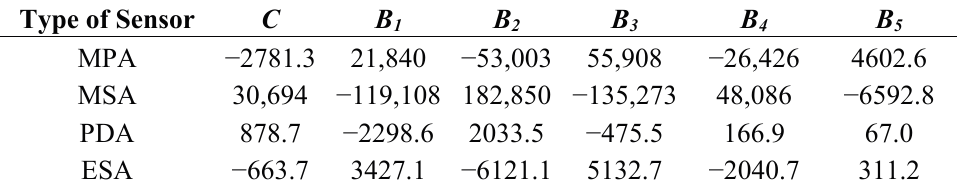
Table 3. Coefficients of the fitting equation of AFs.